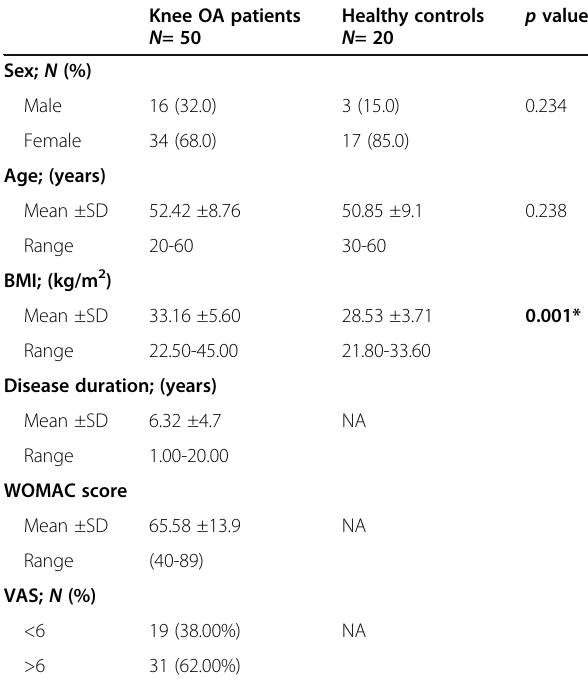
Table 1 Socio-demographic data and clinical assessment of the studied population ( N = 70) Knee OA patients Healthy controls N = 50 N =